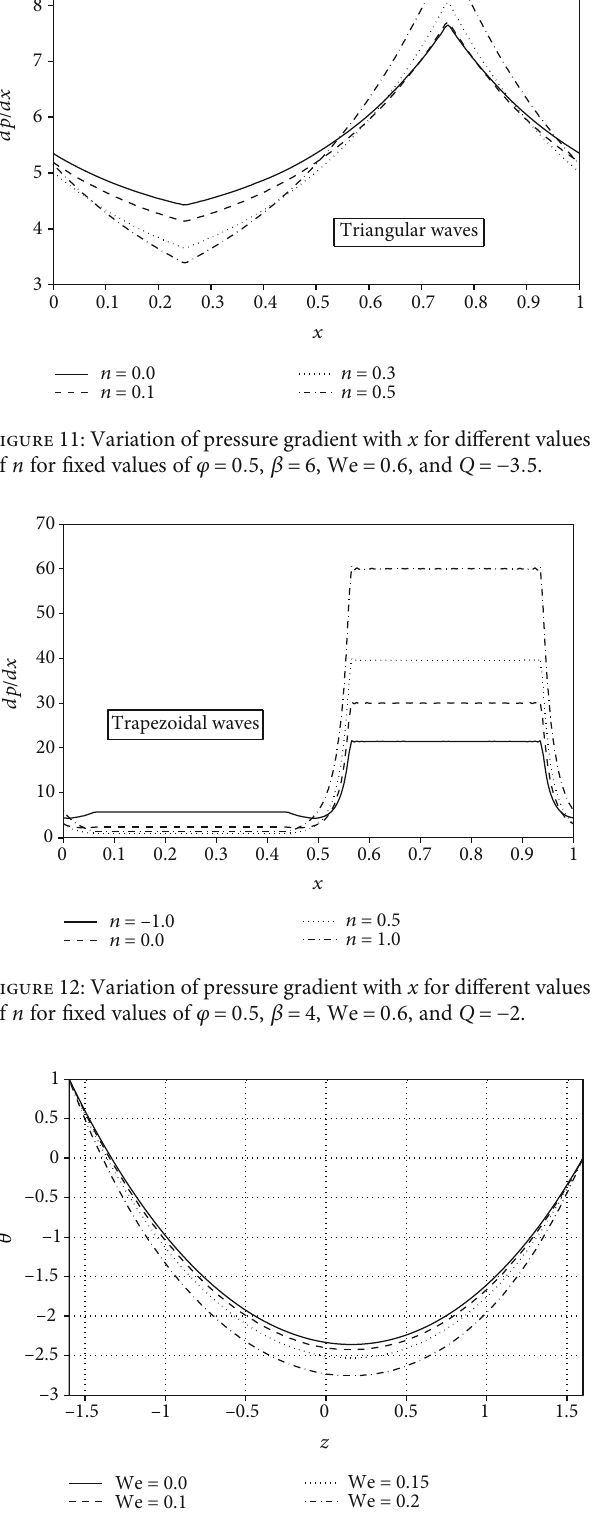
Figure 13: Temperature pro fi le for di ff erent values of We for fi xed values of φ = 0 : 6 , x = 0 , β = 0 : 5 , n = 2 , Q = − 1 , y = 1 , Pr = 0 : 5 , and Ec = 0 : 2